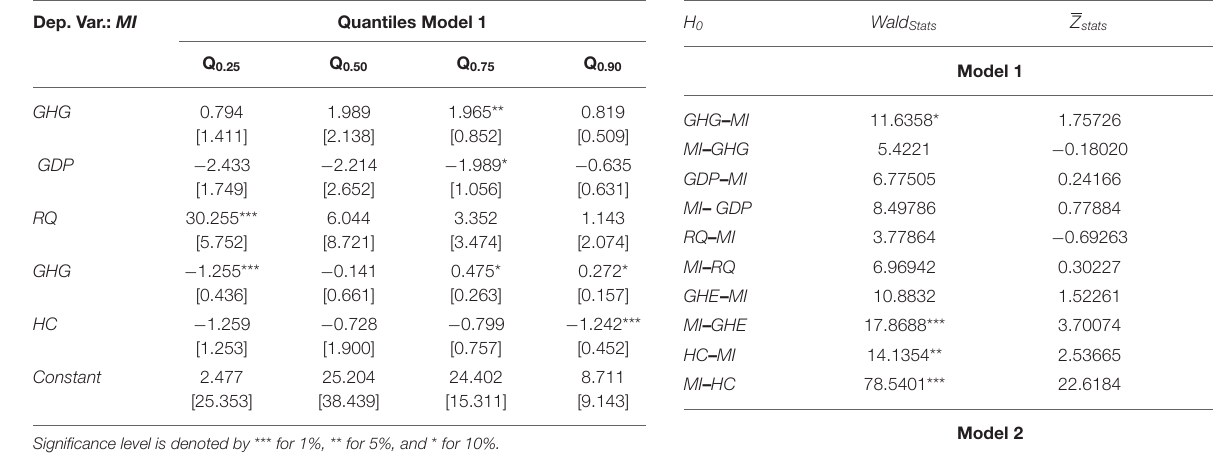
TABLE 9 | Dumitrescu-Hurlin panel